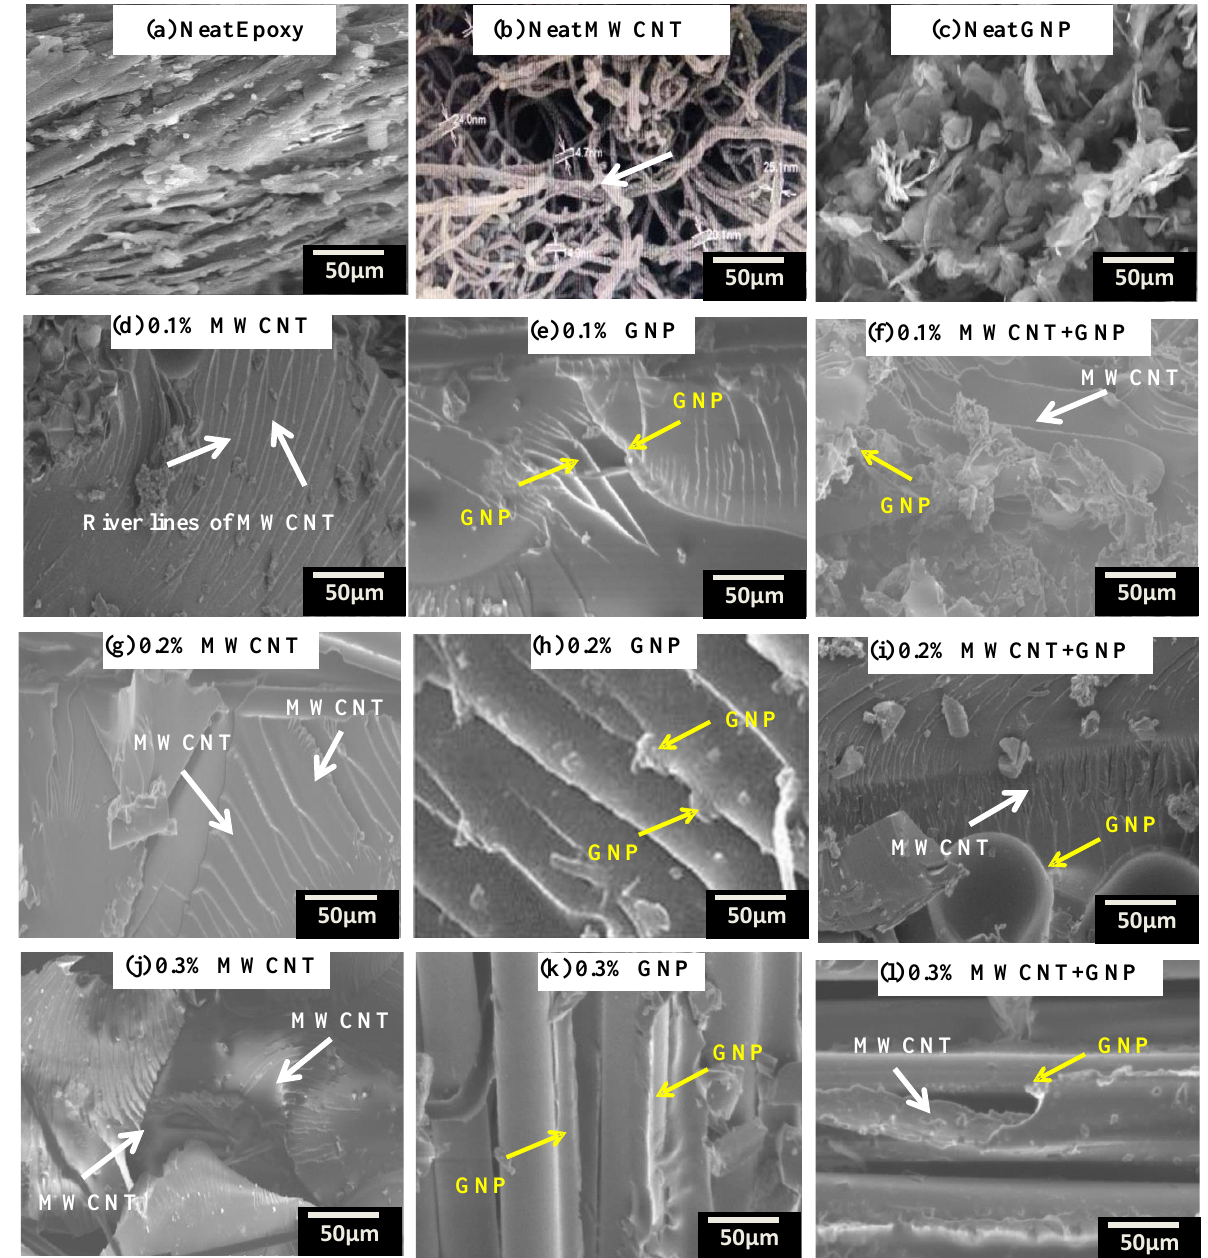
Figure 6. Dispersion of nanofillers in epoxy at different weight percentages.